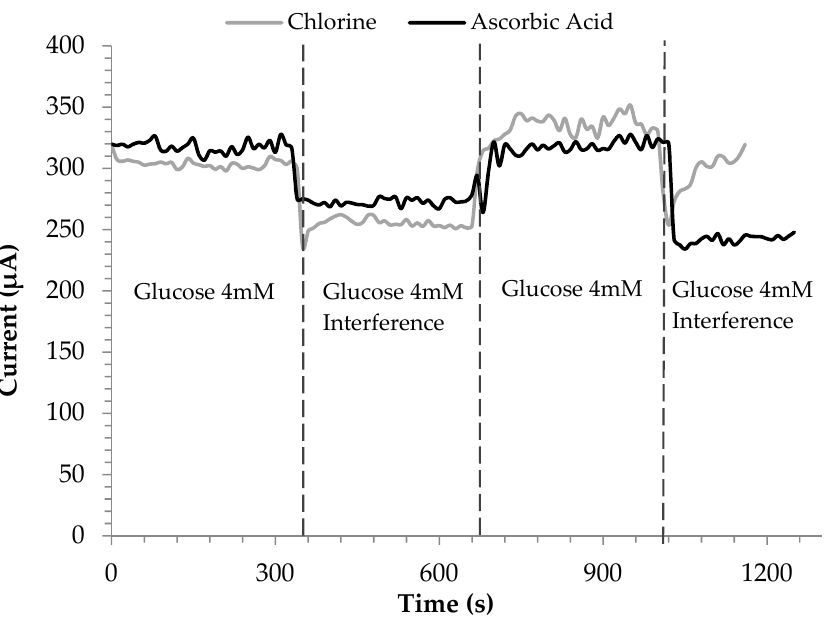
Figure 12. Pulsed Amperometric response of the copper oxide electrode in the presence of common interfering substances and 4 mM of glucose at +0.55 V (vs. Ag/AgCl) in 0.1 M NaOH (pH 13). 0.1 mM ascorbic acid and 0.1 M chlorine .